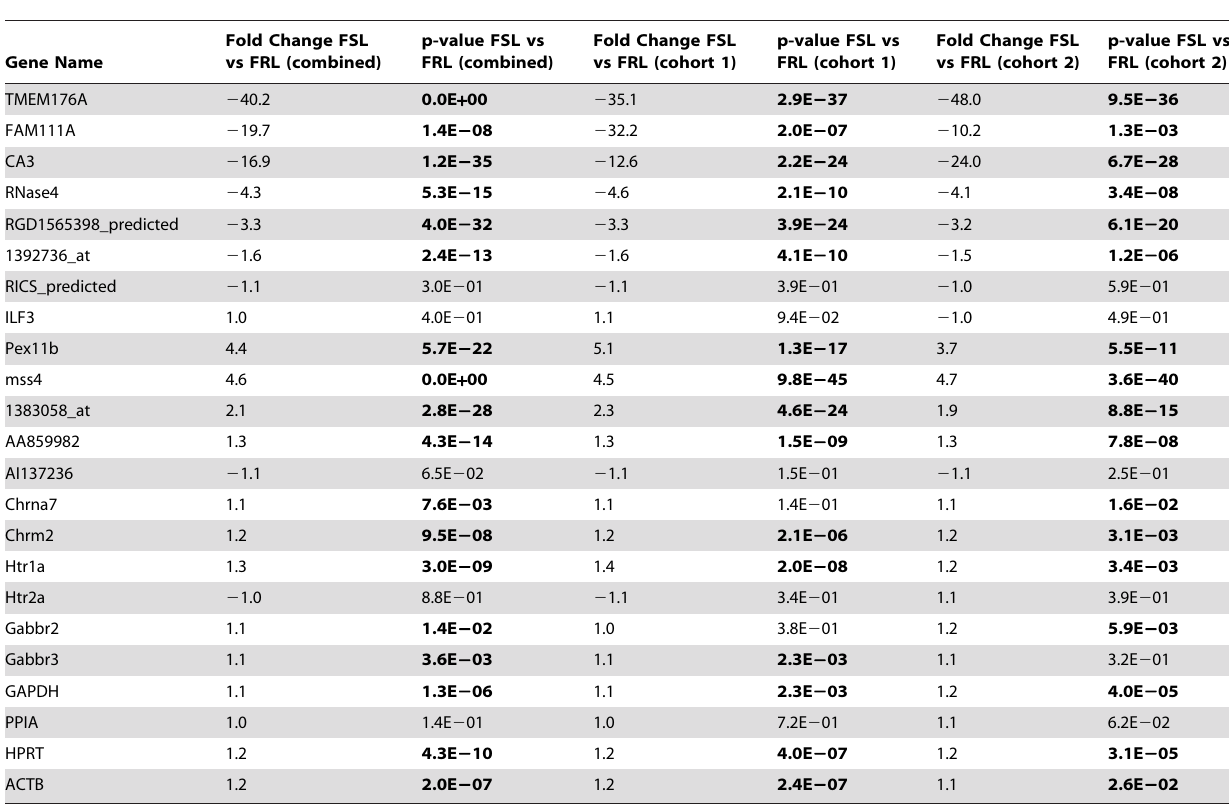
Table summarising output of mixed model analysis of variance analysis of the real-time PCR data for P/FC. Column 1 shows gene name; columns 2 and 3 show fold change and p-value respectively for the combined cohort analysis; column 4 and 5 show fold change and p-value respectively for cohort 1; columns 6 and 7 show fold change and p-value respectively for cohort 2.